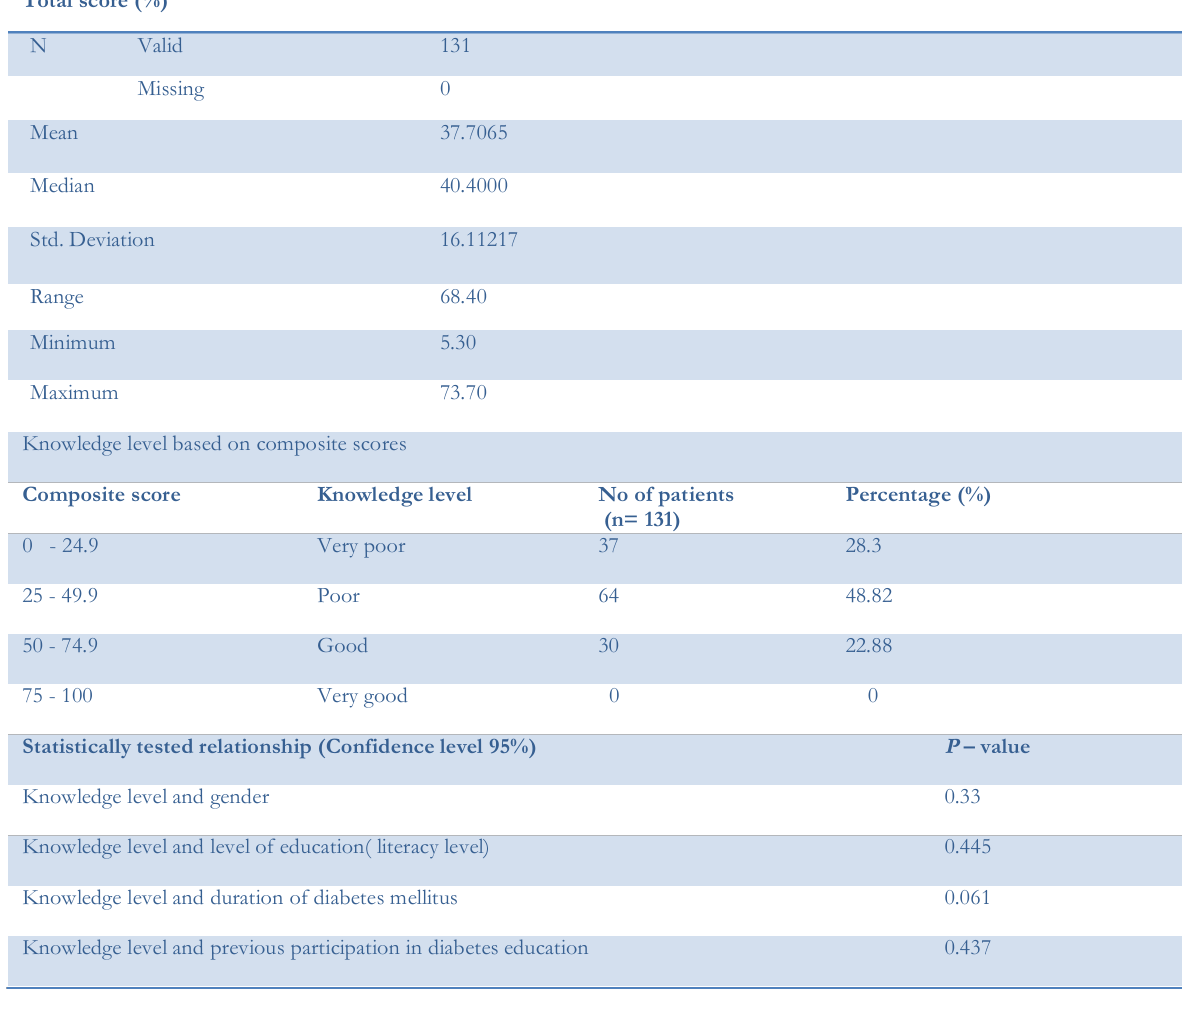
Table 2: Knowledge levels of diabetes mellitus and